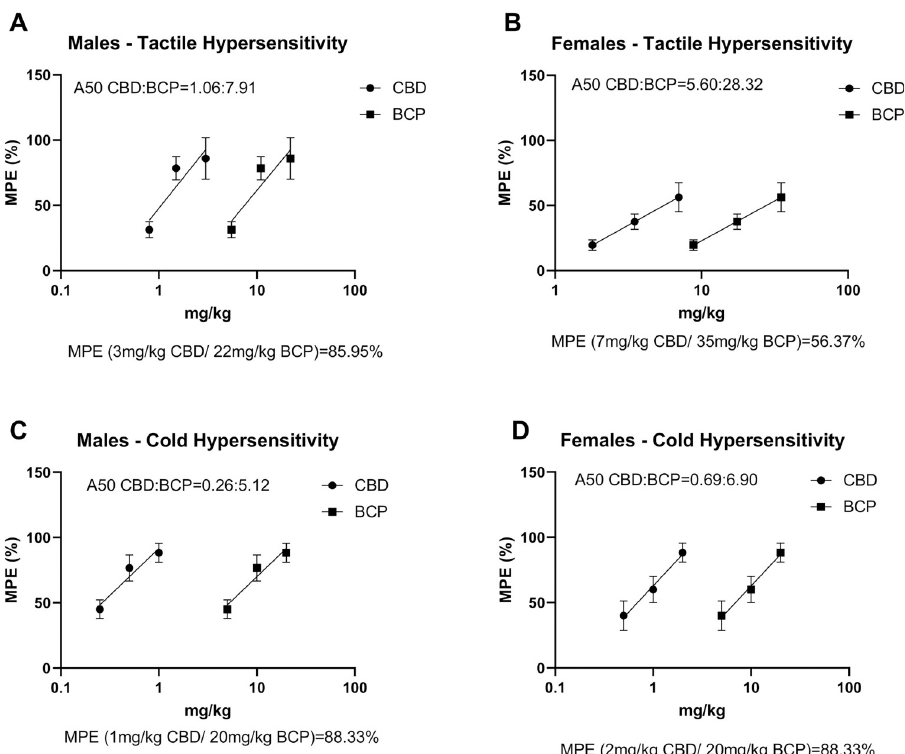
Fig 6. Dose response curves for antinociceptive effects of CBD and BCP in combination in males and females. Dose response curves for the effect of CBD:BCP on mechanical paw withdrawal threshold in A) males and B) females and acetone responses in C) males and D) females. A50 for each drug in combination is displayed for each test. %MPE for the maximal doses of both drugs in combination is shown for each test. Data are shown as % maximal possible effect (% MPE) ±